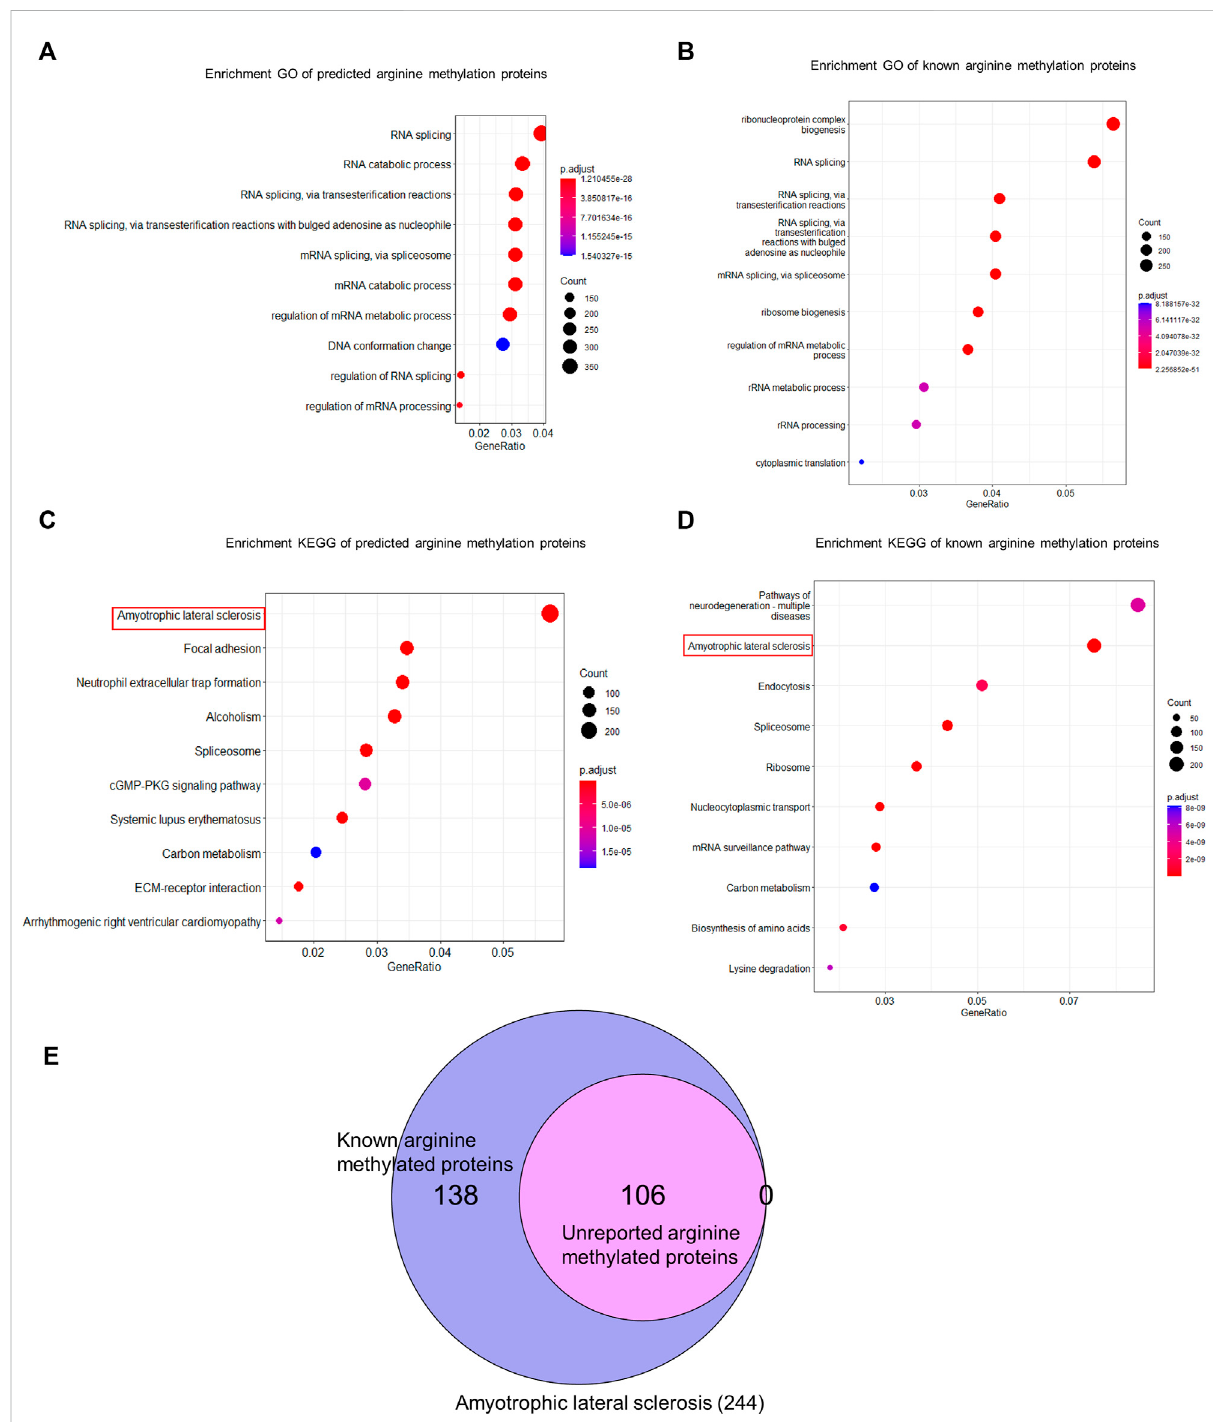
FIGURE 6 GO and KEGG analysis of human arginine methylated proteome. (A) GO enrichment analysis of arginine methylated proteome predicted by CNNArginineMe. (B) GOEnrichmentanalysisofknownargininemethylatedproteins. (C) KEGGenrichmentanalysisofargininemethylatedproteome predicted by CNNArginineMe. (D) KEGG enrichment analysis of known arginine methylated proteins. (E) Venn Diagram of reported and predicted arginine methylated proteins involved in the